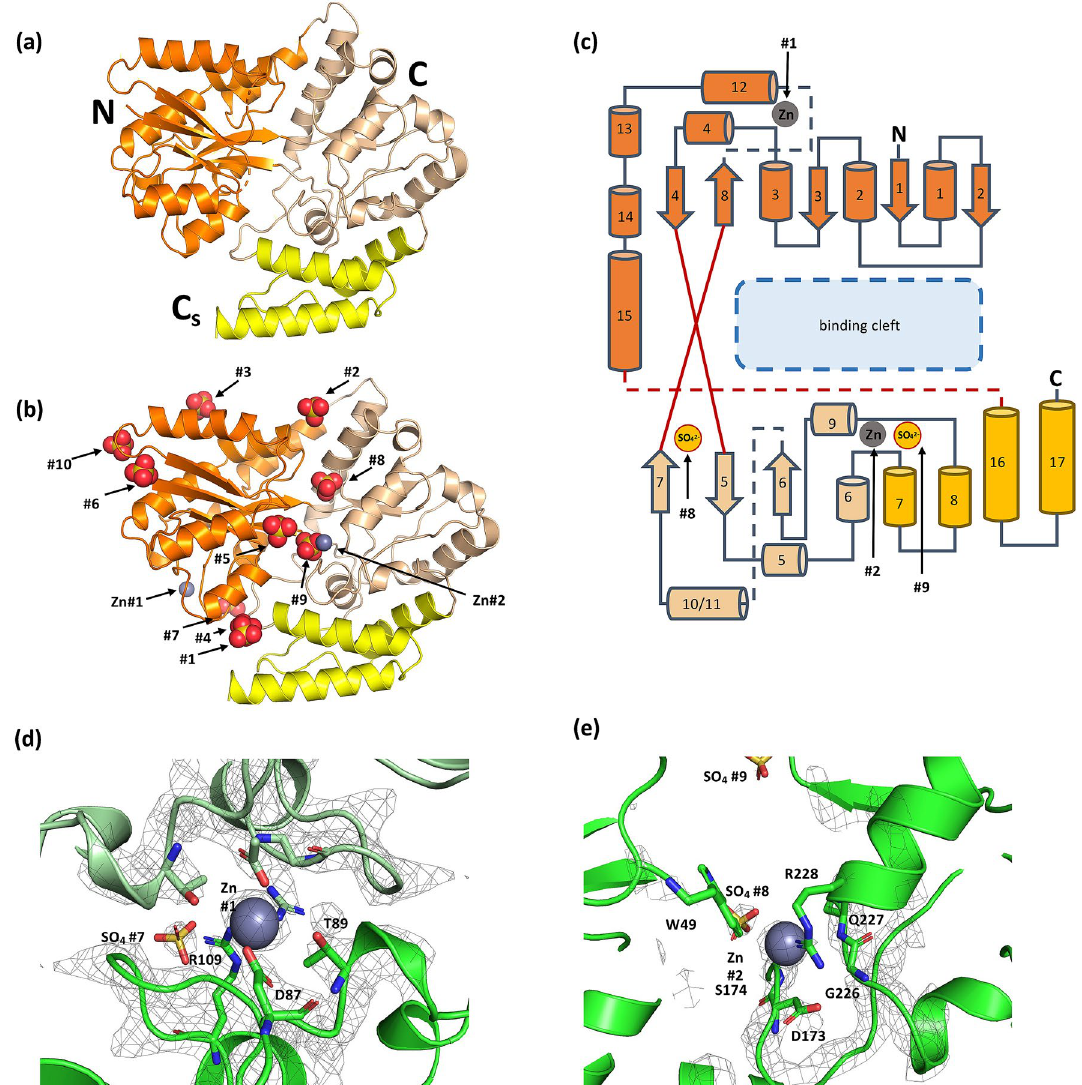
Figure 3. Crystal structure of MsBP and Zn-MsBP. (a) The cartoon representation of the MsBP structure showing the N-terminal domain (orange), C-terminal domain (wheat), and a C-terminal subdomain (yellow) characteristic of structural cluster D-I. (b) Structure of Zn-MsBP with identical domain colouring includes bound sulphate (red) and zinc ions (grey). (c) The topology map for MsBP (and Zn-MsBP), highlighting the approximate location of the bound zinc sites and sulphate ions found in the binding cavity. Dashed lines indicate elements passing behind the plane. The substrate-binding cleft is shown (blue box). (d) The crystal structure of Zn-MsBP (6WPM) is shown with electron density overlaid at Zn site 1 and (e) Zn site 2. Electron density is shown as 2F 0 -F C map contoured at 2σ. For Zn site 1, the monomer within the unit cell is shown as dark green, with the neighbouring monomer from the adjacent unit cell shown in light green contributing identical co-ordinating